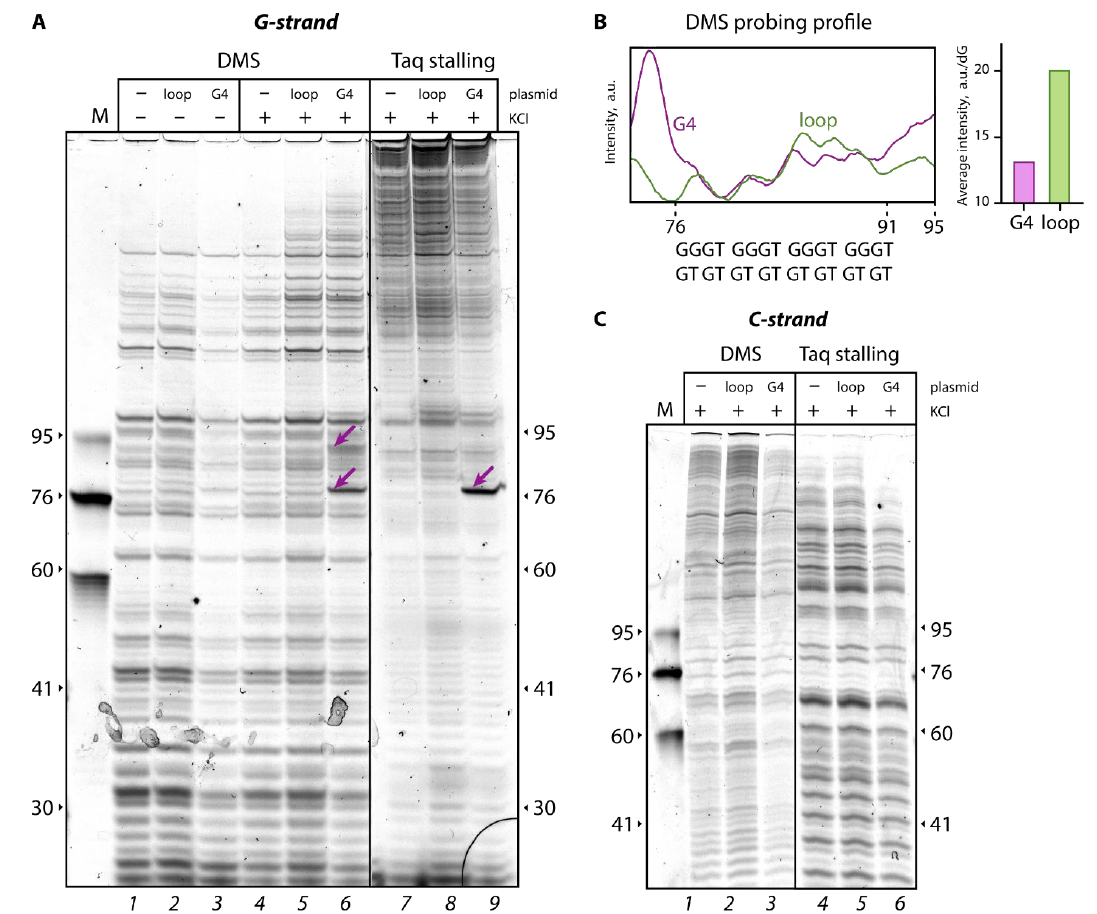
Figure 2. Monitoring of the G4 structure in engineered plasmid DNAs. ( A ) Data from DMS probing followed by Taq polymerase primer extension (lanes 1 – 6 ) and Taq polymerase stop assay (lanes 7 – 9 ) for the G-strand. TAMRA-labeled primer G (Table 2) was used. Unmodified pUC-MMR plasmid (lanes 1 , 4 , and 7 ), loop-pUC plasmid (lanes 2 , 5 , and 8 ), and G4-pUC plasmid (lanes 3 , 6 , and 9 ), designated as – , loop, and G4, respectively, used in the comparative experiments. The absence or presence of K + in reaction was indicated by “−“ or “+”, respectively. Oligonucleotide products of the Taq polymerase stop assay and DMS probing followed by primer extension reaction were an- alyzed by 10% polyacrylamide gel electrophoresis under denaturing conditions. The length of the oligonucleotides used as markers is shown to the left and right of the electrophoregrams. The ar- rows correspond to the high-intensity bands discussed in the text. ( B ) Densitometric profile of flu- orescence primer extension products after DMS modification and piperidine solution cleavage for the 76 – 95-nt region of lanes 5 and 6 in the electrophoregram in the ( A ). Mean band intensities for one of the twelve guanosines in the d(GGGT) 4 motif (G4-pUC plasmid) and one of the eight gua- nosines in the d(GT) 8 sequence (loop-pUC plasmid) are plotted on the right. ( C ) Data from DMS probing followed by primer extension reaction (lanes 1 – 3 ) and Taq polymerase stop assay (lanes 4 – 6 ) for the partially complementary C-strand: unmodified pUC-MMR plasmid (lanes 1 and 4 ), loop-pUC plasmid (lanes 2 and 5 ), G4-pUC plasmid (lanes 3 and 6 ). TAMRA-labeled primer C (Table 2) was used. The designation for plasmids and other labels are the same as in ( A ). For the direct detection of the G4 structure incorporated into plasmid constructs, DMS chemical probing followed by primer extension reaction was used as an inde- pendent method [29]. This reagent most effectively methylates the N7 position of gua- nine residues, and the reaction efficiency depends on the DNA secondary structure. DMS modification leads to easy depurination and strand cleavage upon treatment with pi-